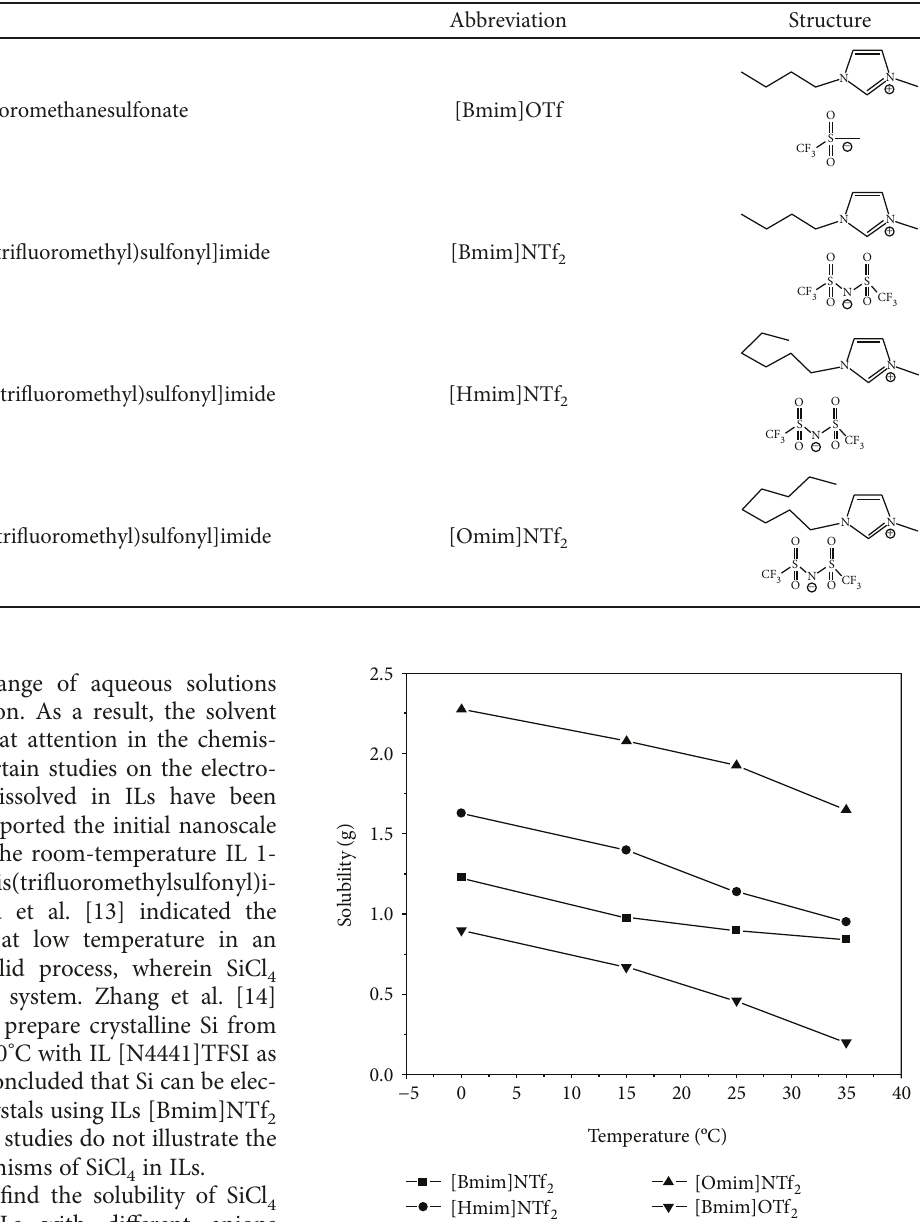
Table 1: Ionic liquids used in the study.